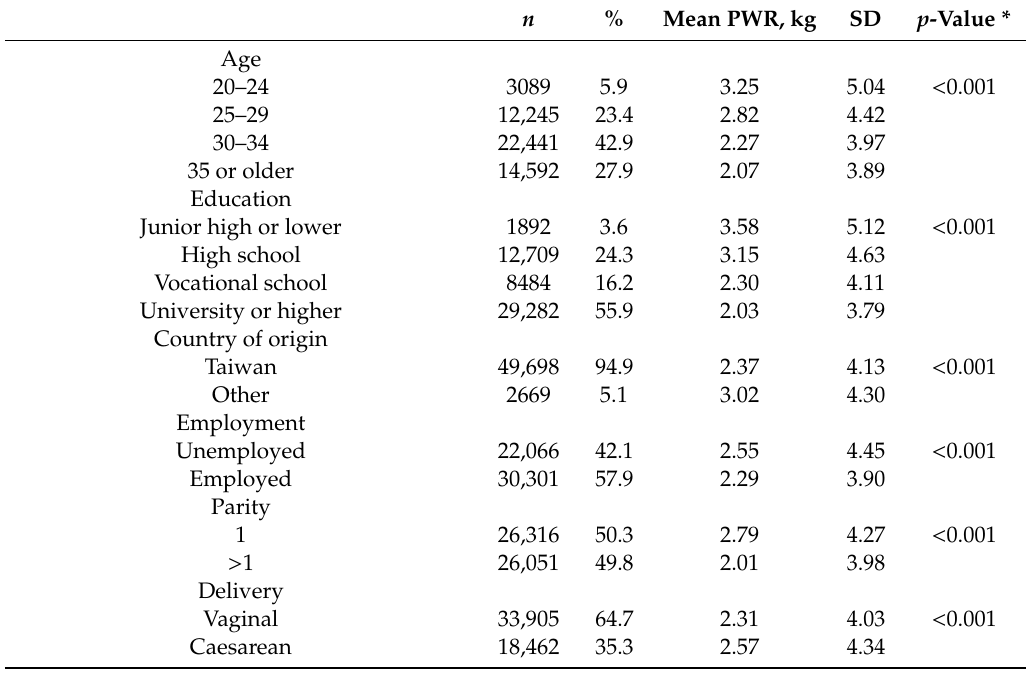
Table 1. Characteristics of breastfeeding survey respondents ( N =